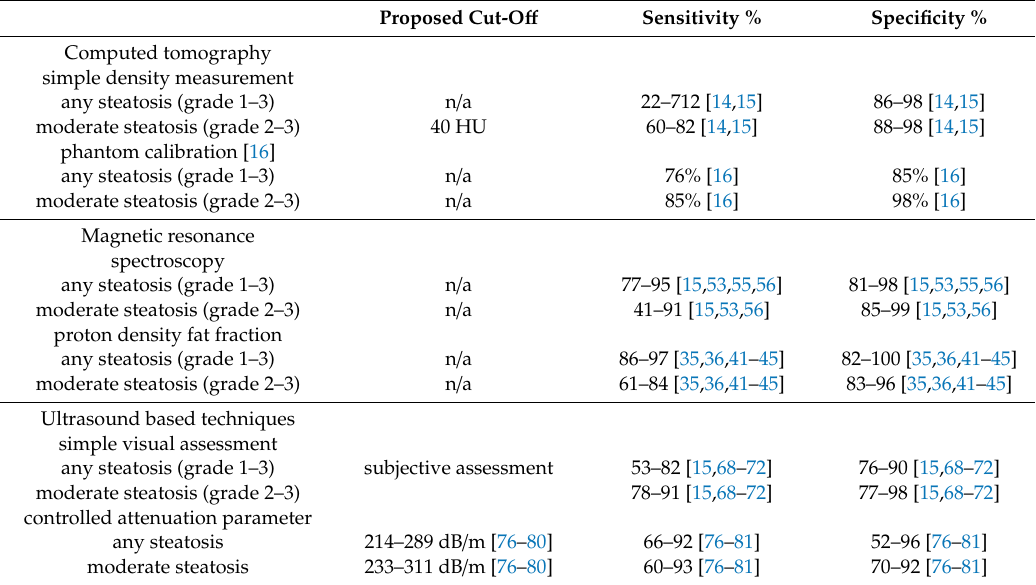
Table 1. Summary of the diagnostic parameters of di ff erent methods of steatosis assessment.